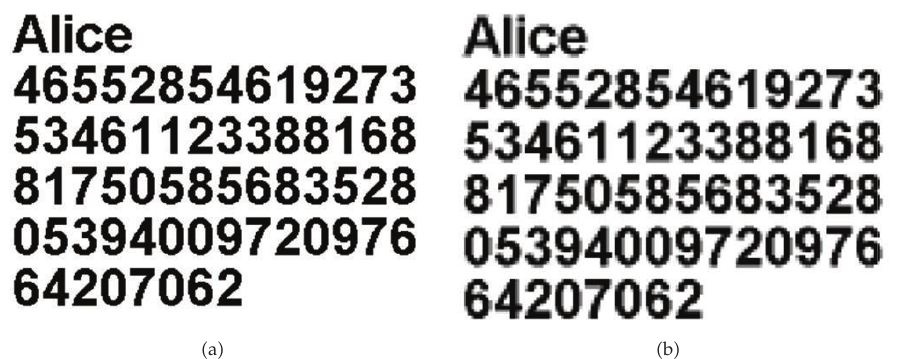
Figure 3: User name and hashed